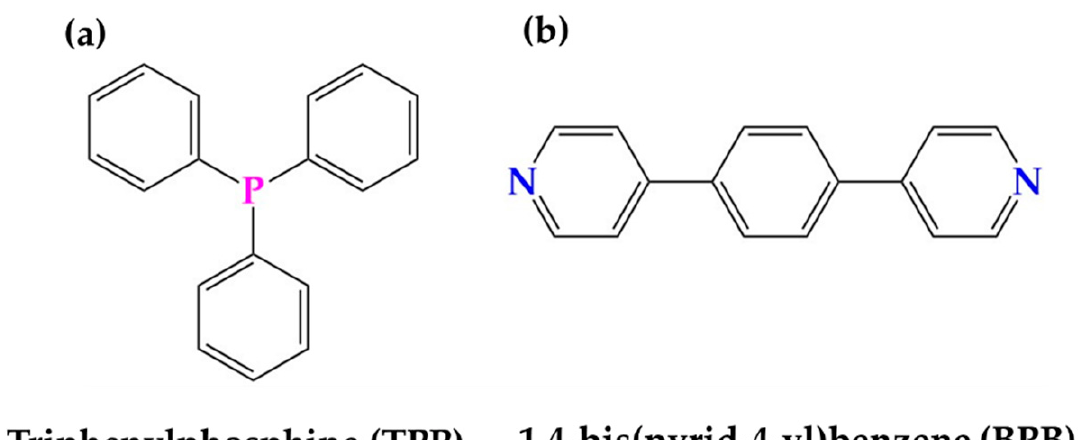
Figure 1. Molecular structures of ( a ) TPP and ( b ) BPB.